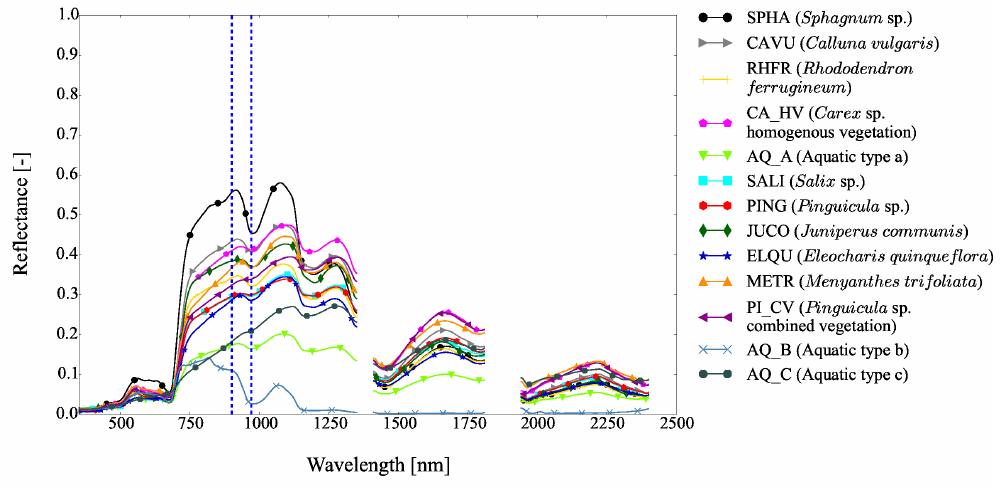
Figure 6. Mean spectral reflectance of the 13 vegetation types. Dashed lines represent the wavelengths used by Water Index (WI).